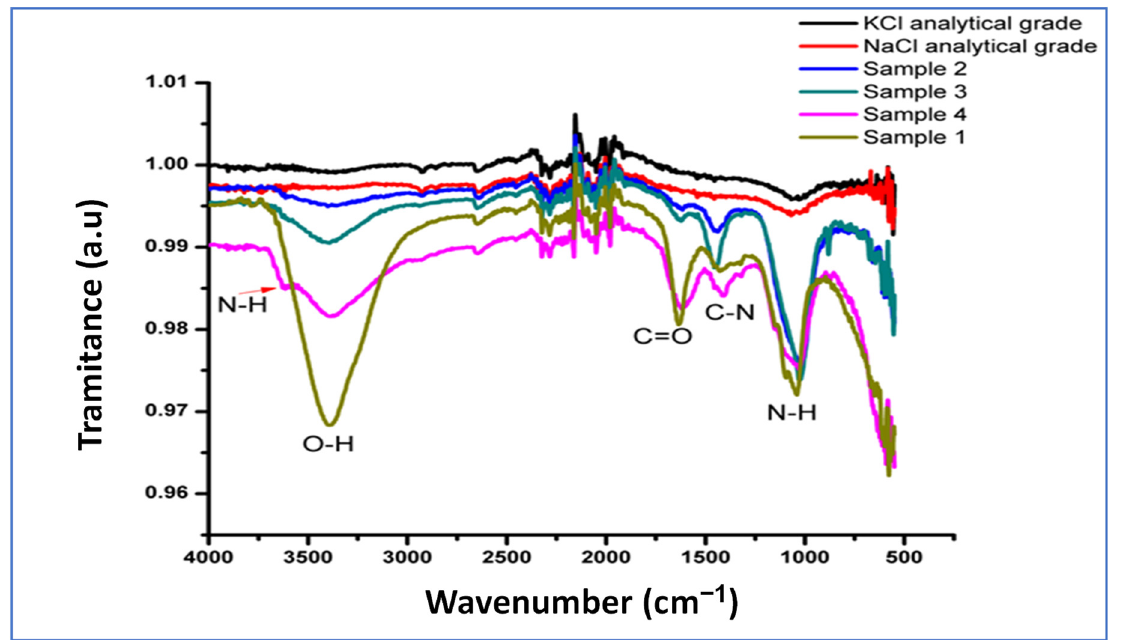
Figure 6. IR spectra of mineral samples with drying treatment. Sample 1: Blanco; Sample 2: BPC; Sample 3: Problema and Sample 4: Bueno.